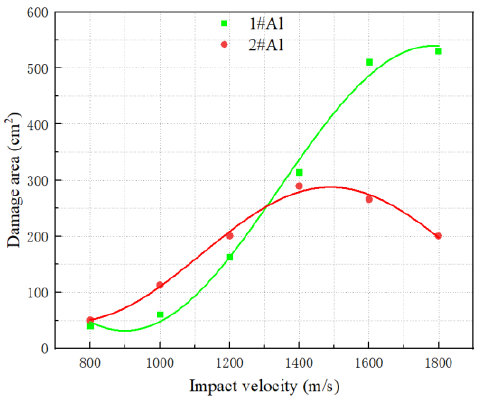
Figure 10. Damage area of the double-layer target at different impact velocities.